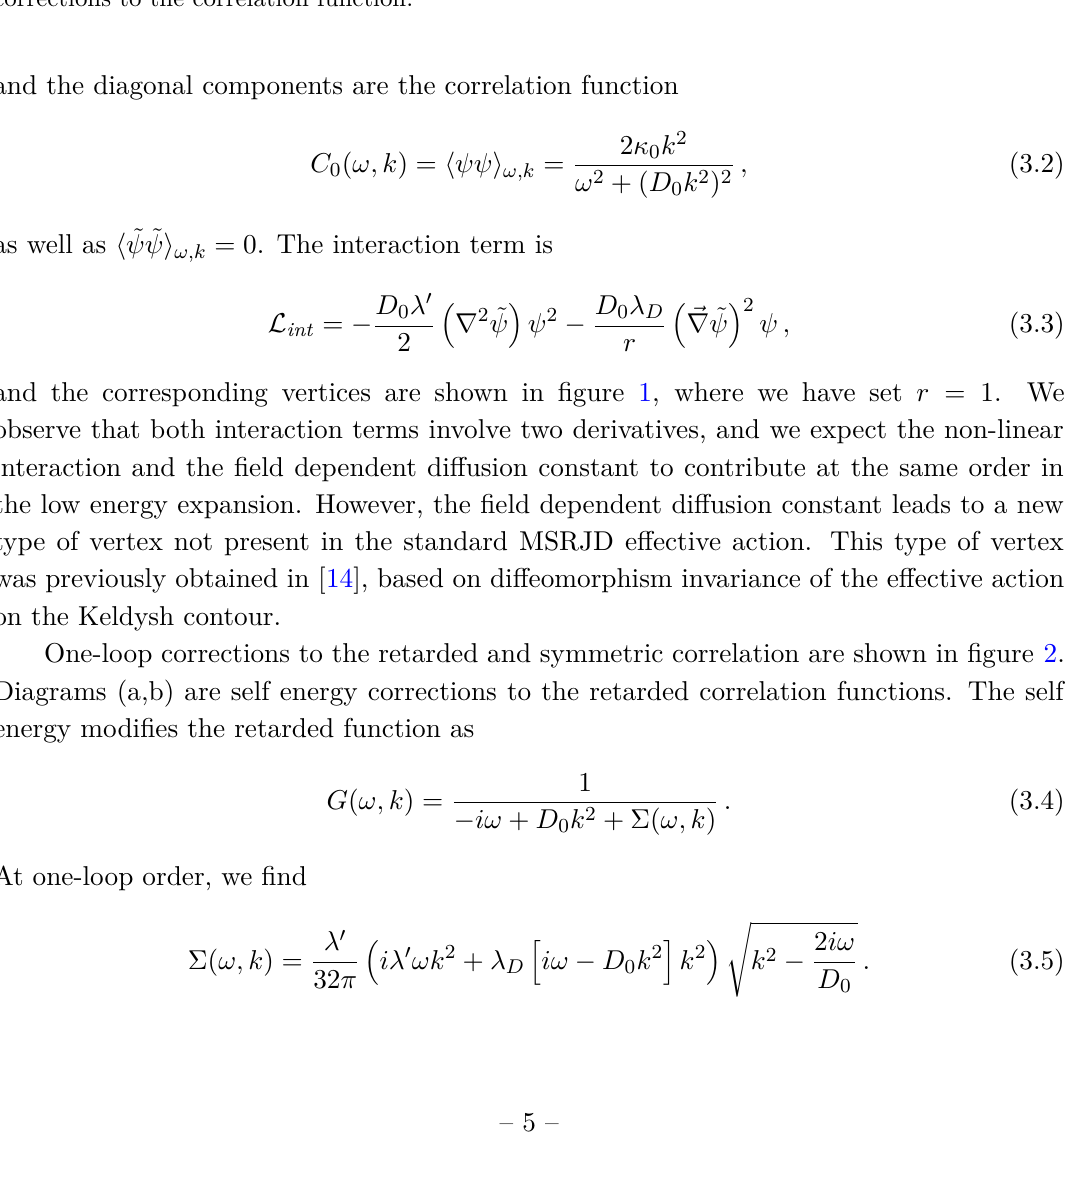
Figure 2. One-loop contributions to the response function (a)-(c) and the correlation function (d)-(e) in model B. Diagram (a) contains only the non-linear interaction, whereas diagram (b) also depends a new vertex generated by the field dependent diffusion constant. Diagram (c) is a new type of diagram that contains the composite operator λ D [ ψ~ ∇ ˜ ψ ] . Diagrams (d,e) are the corresponding corrections to the correlation